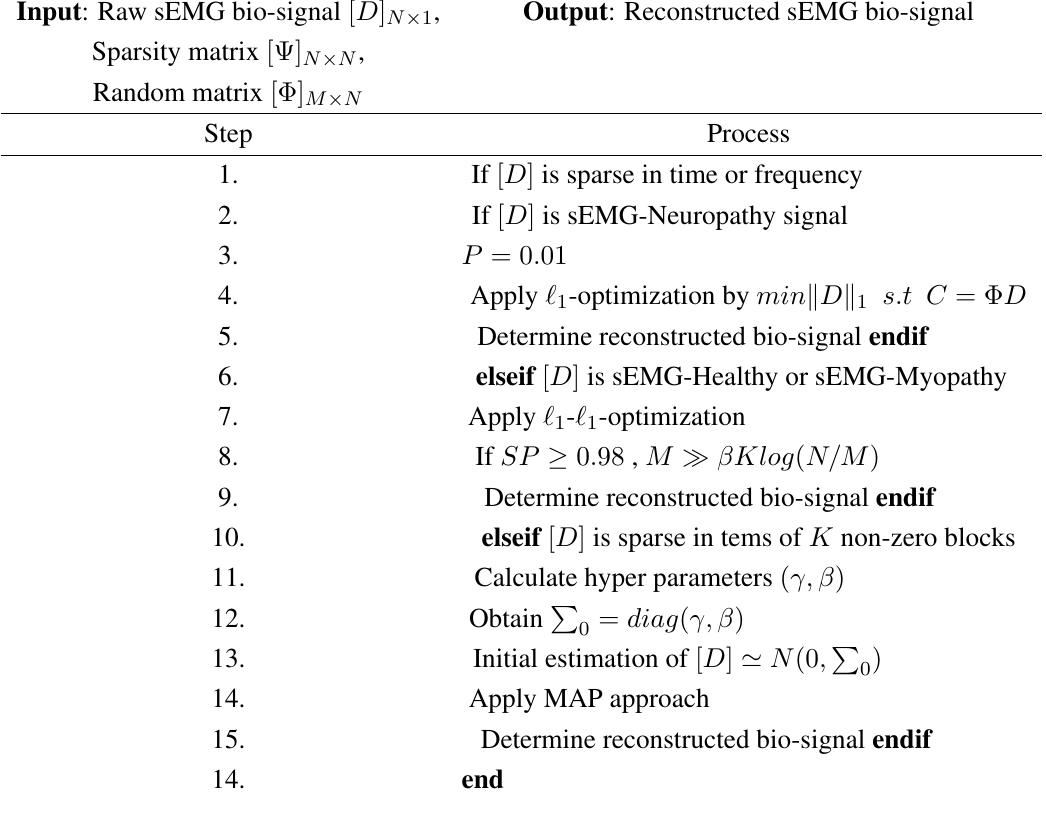
Table 4. Algorithm III: robust reconstruction